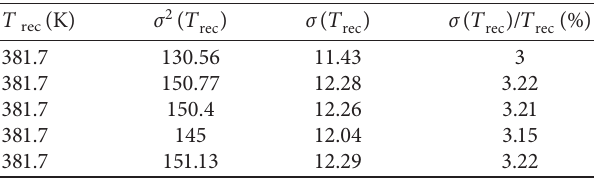
Table 8: Accuracy calculation results of the chopper wheel method at 30 ° .